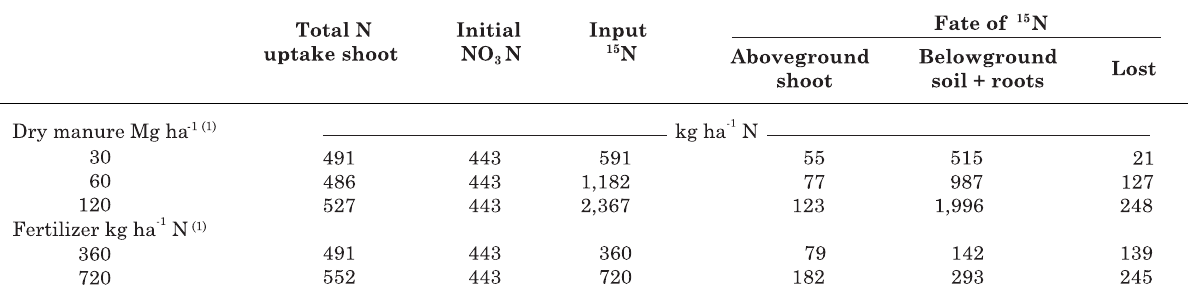
Table 5. Assessment of N budget. Total N uptake shoots, initial soil NO fate of recovered 15 N in aboveground forage, belowground (soil and roots) and lost. after three extraction cycles with annual crops (annual ryegrass-sudan grass-annual ryegrass). Studies were conducted under irrigated greenhouse pots using a representative typical Aridisol from North Central “La Commarca Lagunera” region of